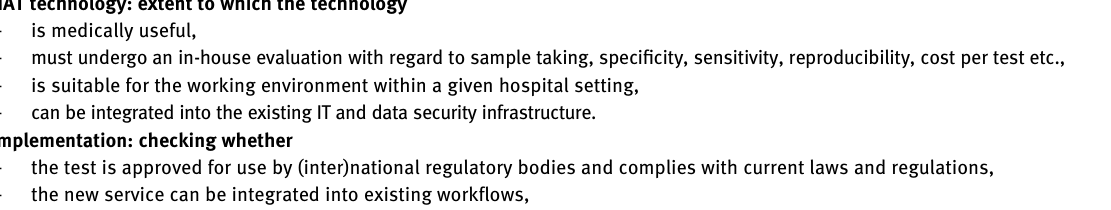
Table  : Selection criteria for using near-patient nucleic acid testing (NAT).